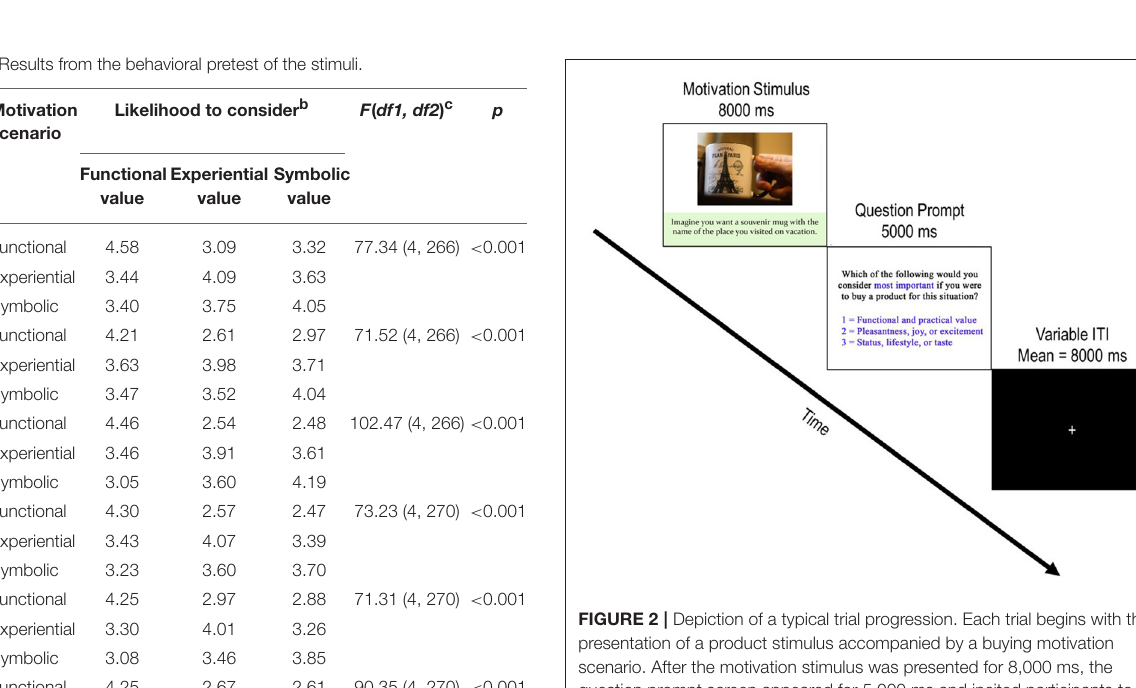
FIGURE 1 | Example stimuli. Examples of three motivational categories for products (e.g., mugs) depicted in pictorial stimuli with instructed buying motivations for the product. (A) Functional, (B) experiential, and (C) symbolic motivation. Note that none of the example images are part of the experimental stimulus material used in the current study. The copyright lies with the authors, and no permission was required for the reproduction of these images.